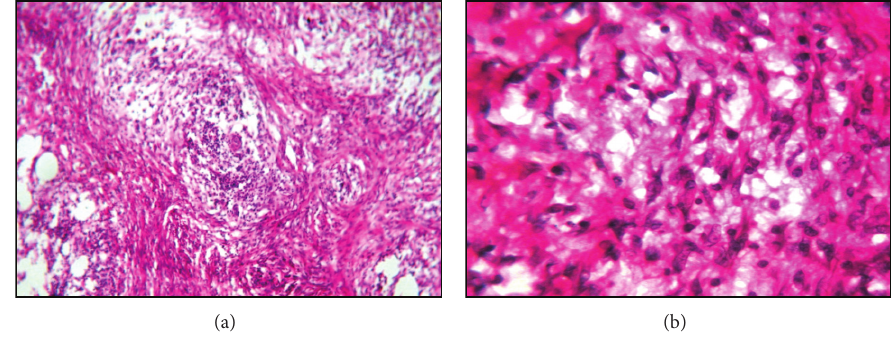
Figure 2: Histology of the omentum. (a) H&E × 100 magnification of omental tissue showing variable sized lobules of fat, separated by fibrocellular bands of reactive fibrosis, infiltrated by acute and chronic inflammatory cells. (b) H&E × 200 magnification. High power view of